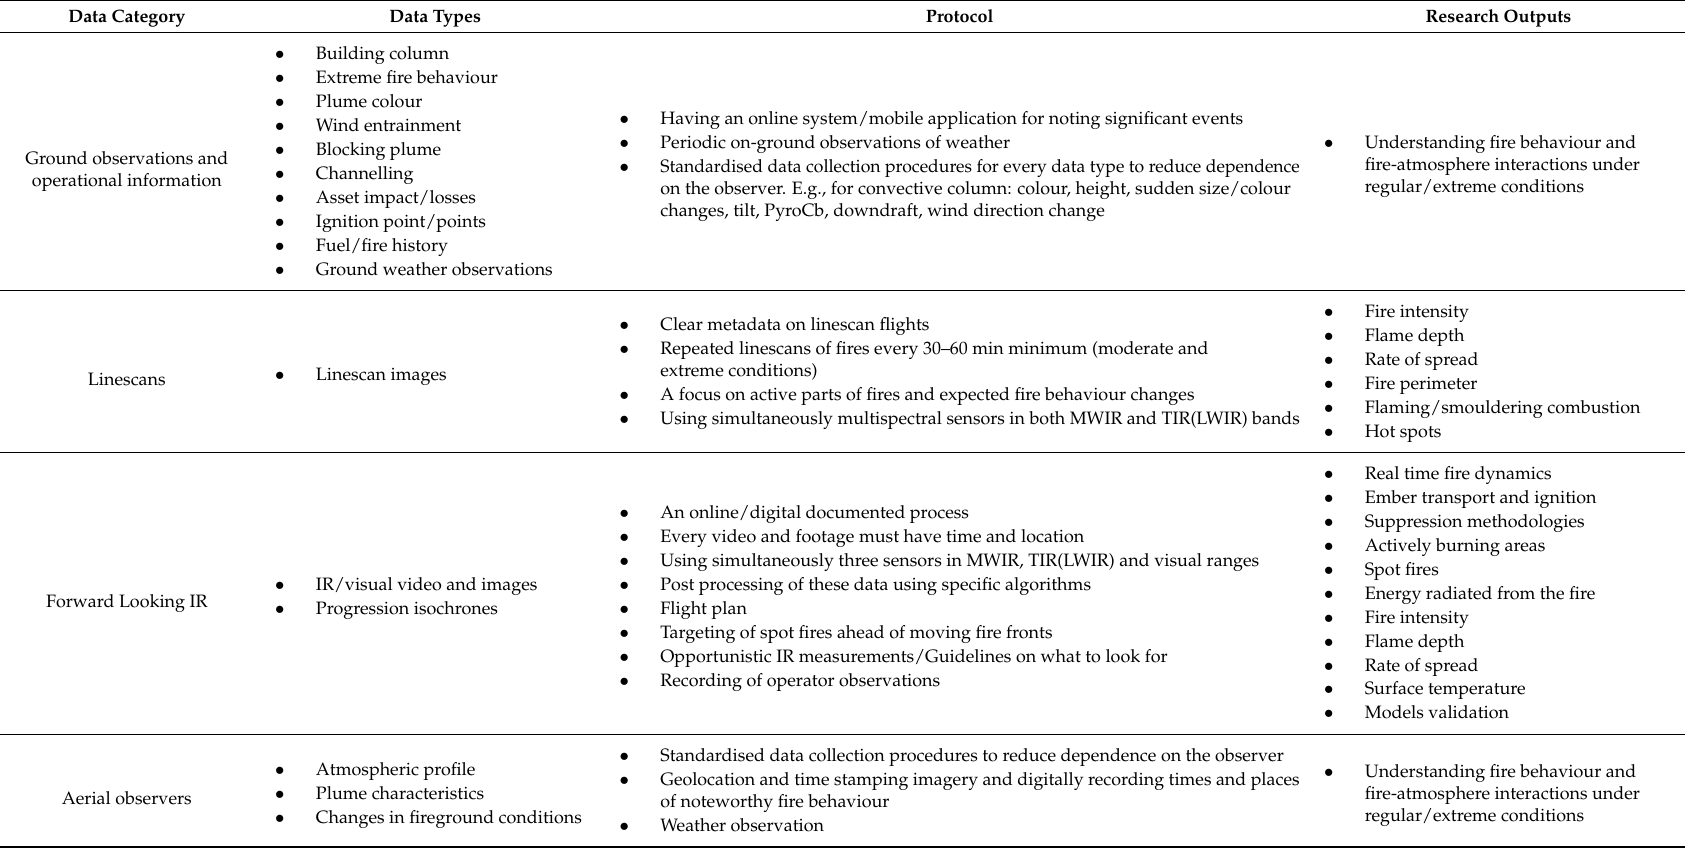
Table 4. List of recommended wildfire-related data and protocols for routine collection using current technologies. It proposes which data should be collected routinely, how and what the research output would